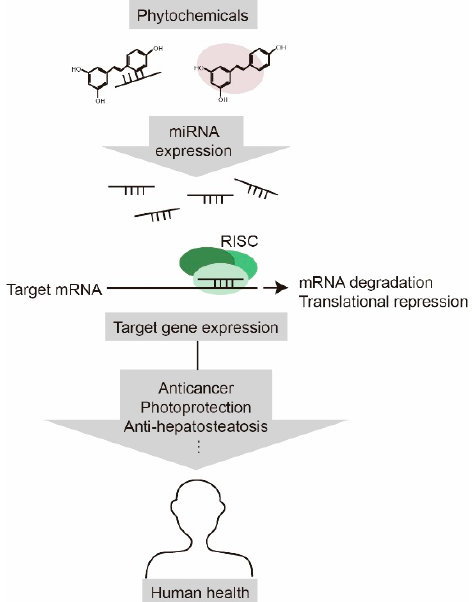
Figure 2. Phytochemicals have a positive impact on human health by regulating miRNA expression. Phytochemicals alter the gene expression profile by modulating miRNA expression, which cause anticancer, photoprotection, and anti-hepatosteatosis effects.